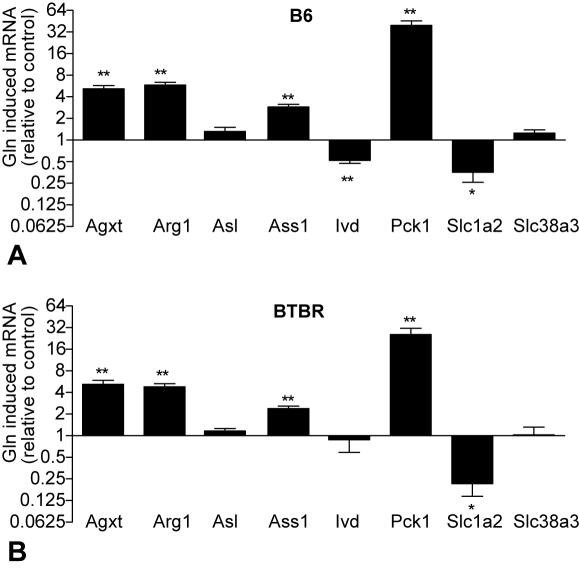
Glutamine changes hepatic gene expression.Hepatocytes from 10-week old lean B6 (A) and BTBR (B) were treated overnight +/− 10 mM glutamine (n = 5 per strain). Transcripts were measured by RT-PCR and expression was normalized to Actb control. Significance calculated based on the difference of delta CT value of each transcript between the untreated and glutamine treated hepatocytes for each individual animal (*p<0.05, **p<0.005).